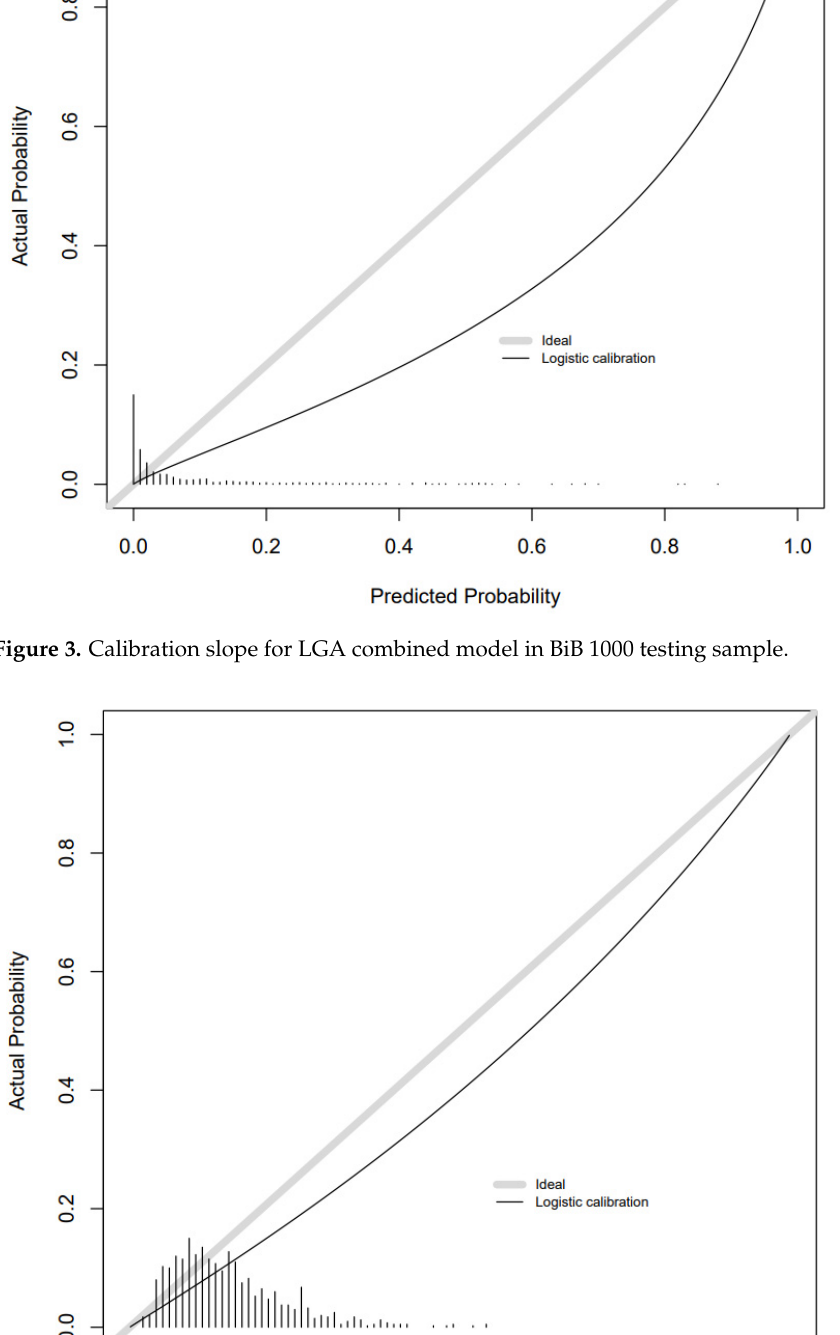
Figure 4. Calibration slope for SGA combined model in BiB 1000 testing sample.